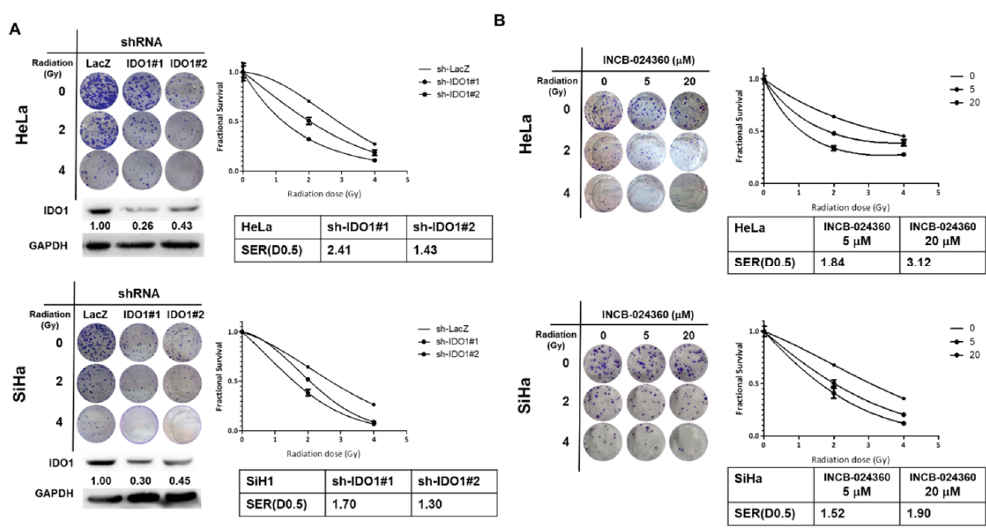
Figure 2. The inhibition of IDO1 sensitizes cervical CSCs to irradiation. Tumorspheres from HeLa and SiHa cells were dissociated into single cell suspension. ( A ) The tumorsphere cells were transduced with lentiviruses carrying IDO1 specific shRNAs (IDO1#1 or IDO1#2) or control LacZ specific shRNA (LacZ) and selected with 2 µ g / mL of puromycin. The surviving cells were than used for the examination of radiosensitivity by gamma-irradiation as an indicated dosage followed by clonogenic assay. The sensitizer enhancement ratio (SER) for an estimated fractional survival of 0.5 (D0.5) was calculated as D0.5(sh-LacZ)/D0.5(sh-IDO1). ( B ) The tumorsphere cells were treated with INCB-024360 as the indicated concentration and performed radiation treatment followed by clonogenic assay. 0.1% dimethyl sulfoxide (DMSO) was used as vehicle control. The data were presented as a fractional survival and SER(D0.5) was calculated as D0.5(DMSO) / D0.5(INCB). All the experiments were repeated three times and data from one experiment were presented.